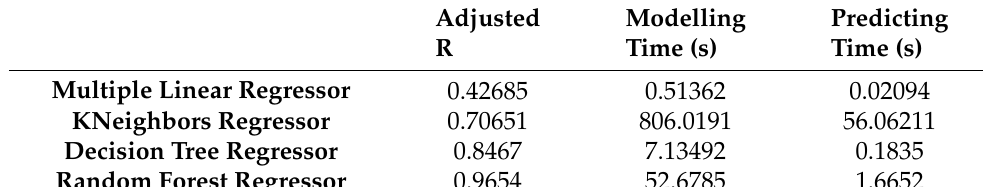
Table 6. Results for different models applied to suggested dataset.